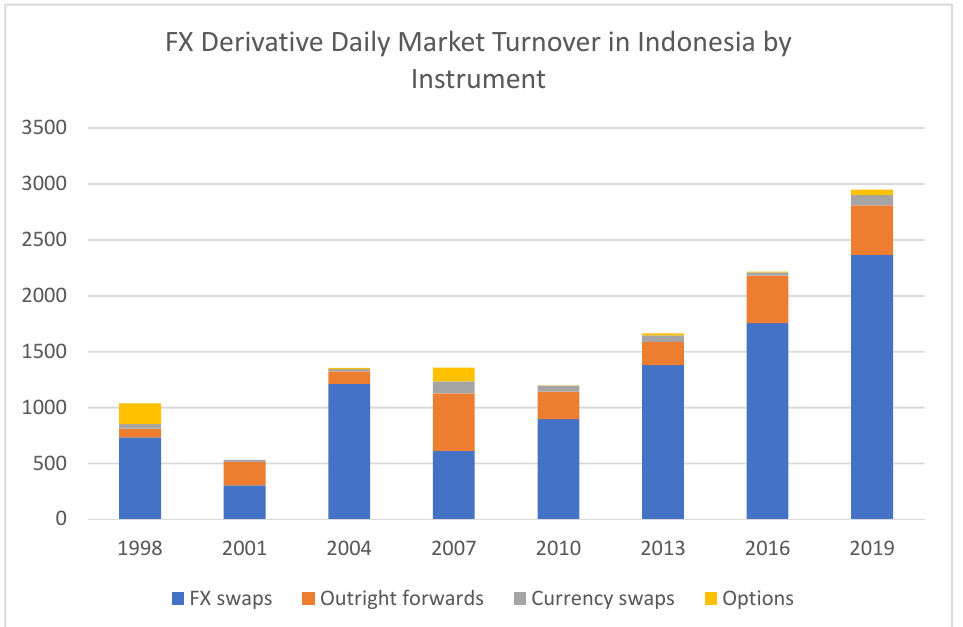
Figure 2. Foreign exchange derivatives daily market turnover in Indonesia by instrument. Source: Bank for International Settlements (2021b) as cited from BIS Triennial Central Bank Survey 2019.